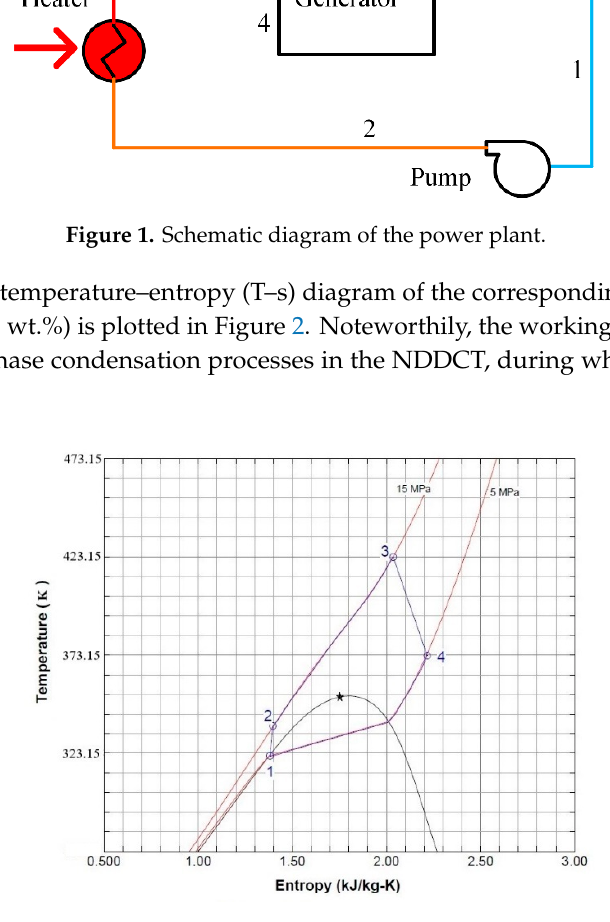
Figure 3. The critical pressure and critical temperature for CO 2 /R161 mixtures.